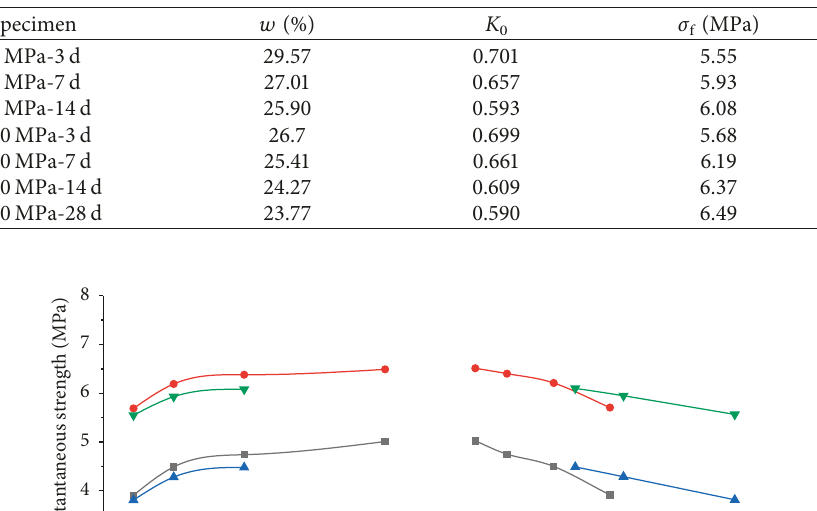
w , and (c) σ f and